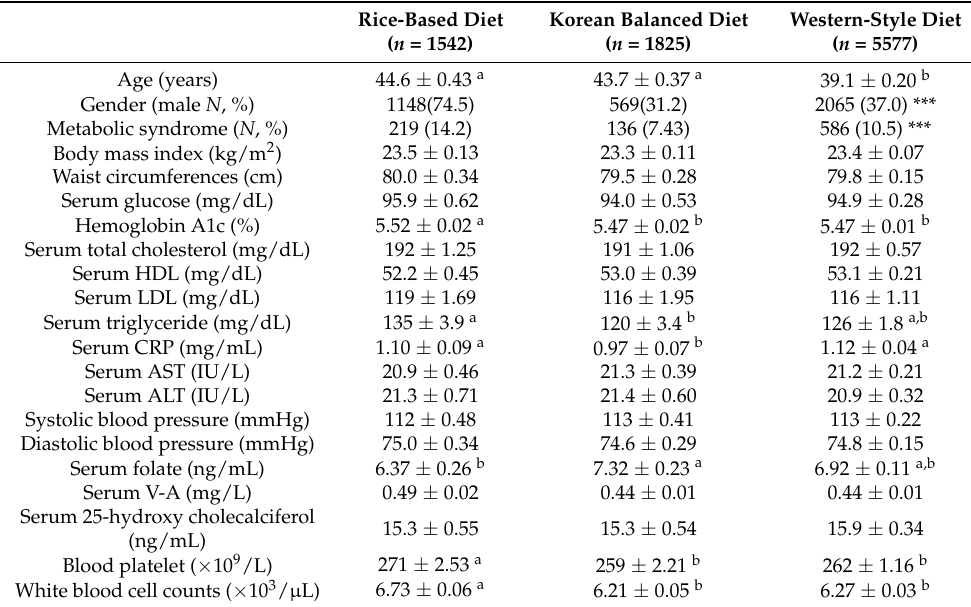
Table 1. Anthropometry and biochemical measurements in three dietary